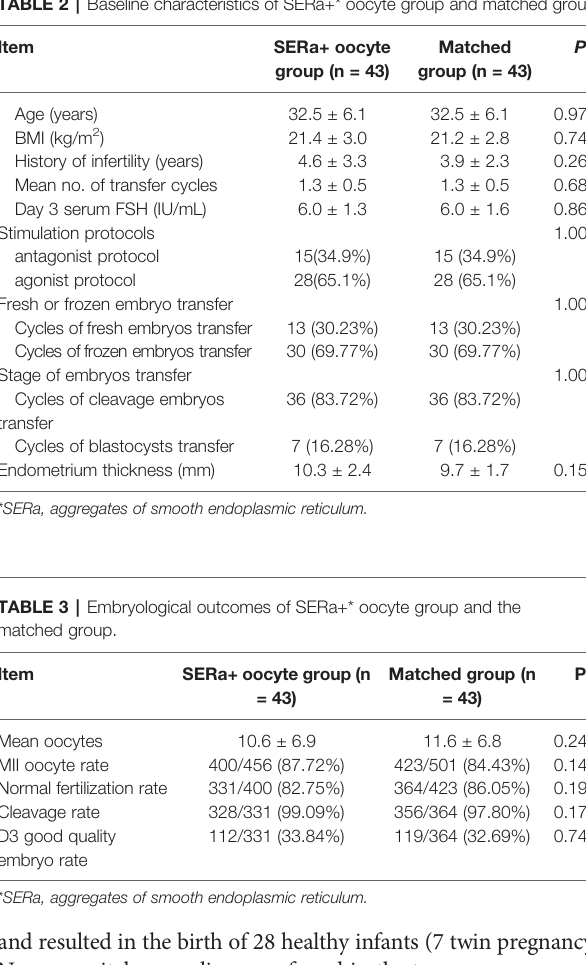
and resulted in the birth of 28 healthy infants (7 twin pregnancy).